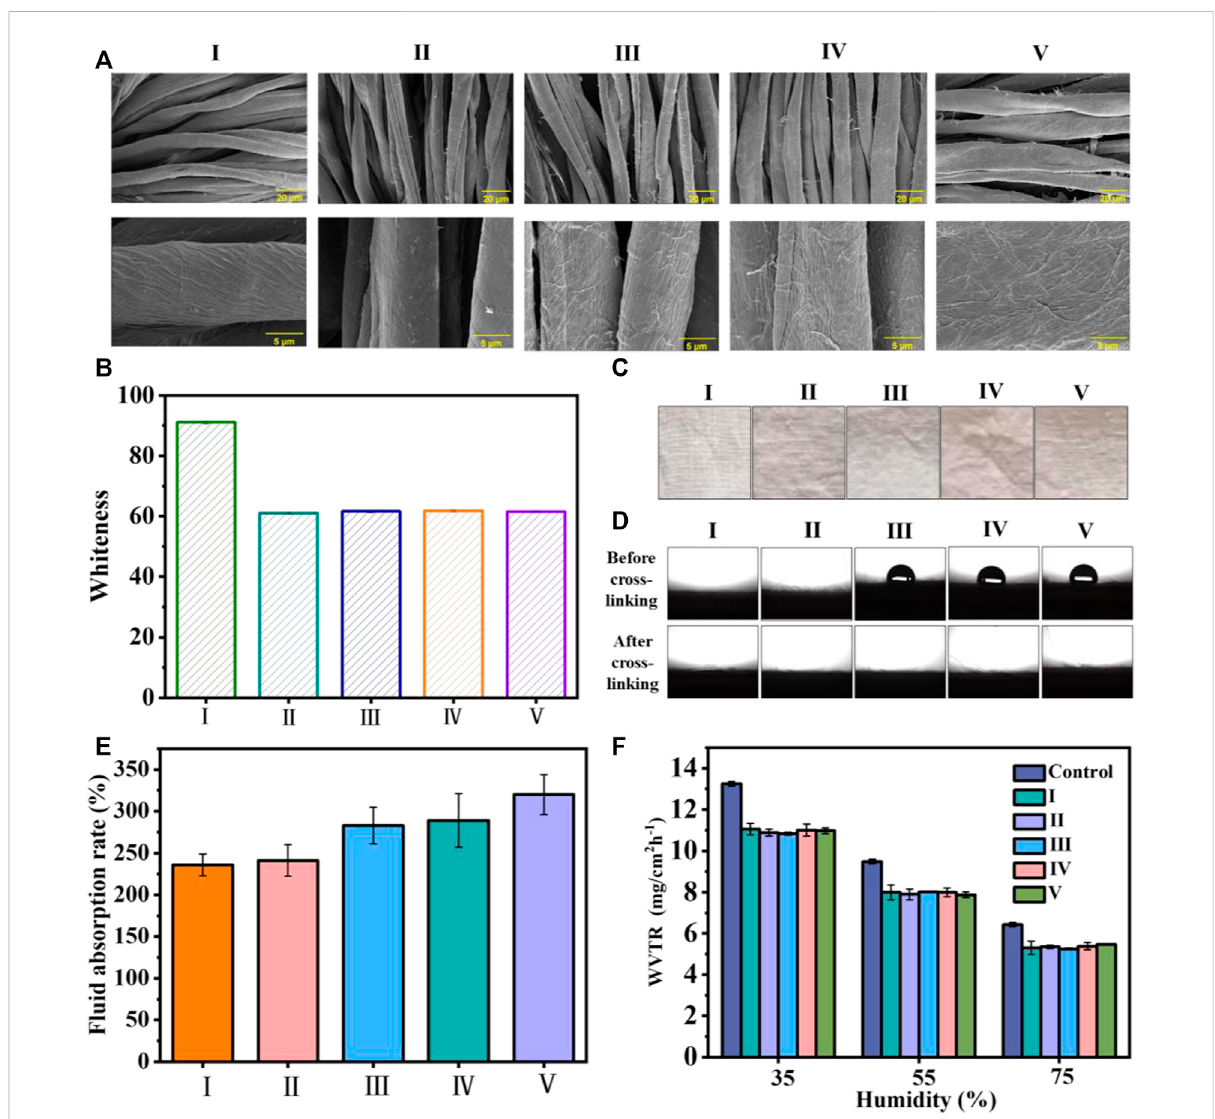
FIGURE 2 (A) SEMimagesofthecottonfabricwithandwithoutcoating (B) thewhitenessstatisticsofthecottonfabricbeforeandaftercoating; (C) images ofthecottonfabrics; (D) images andstatisticalresultsforWCAvalues; (E) liquidabsorption rateoftheuncoatedcottonfabricandcottonfabricswith differentcoatinglayers;and (F)